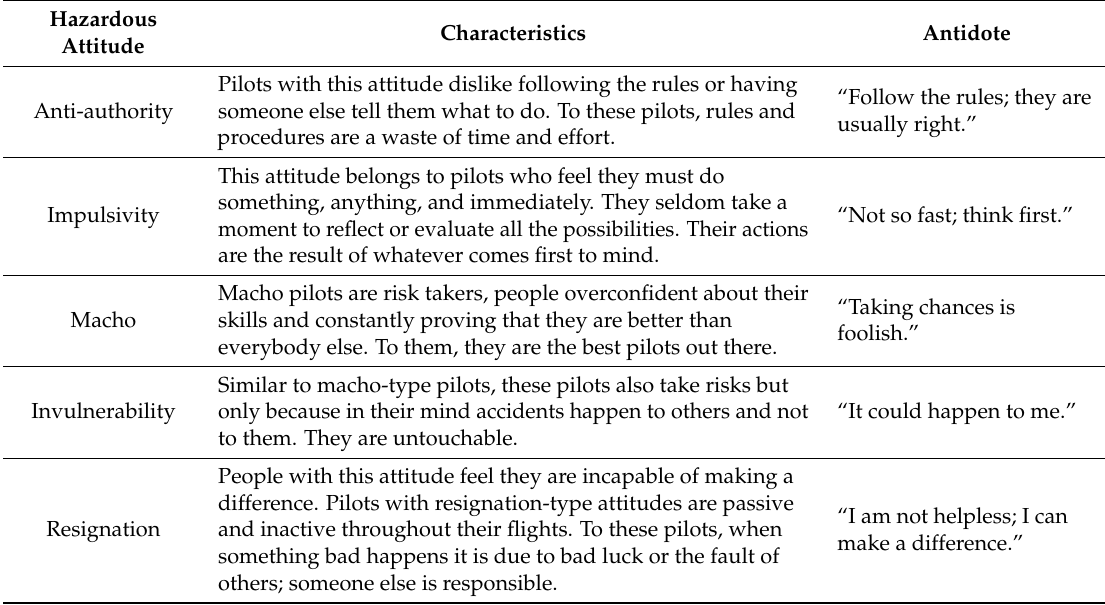
Table 1. Overview of hazardous attitudes with the appropriate antidote